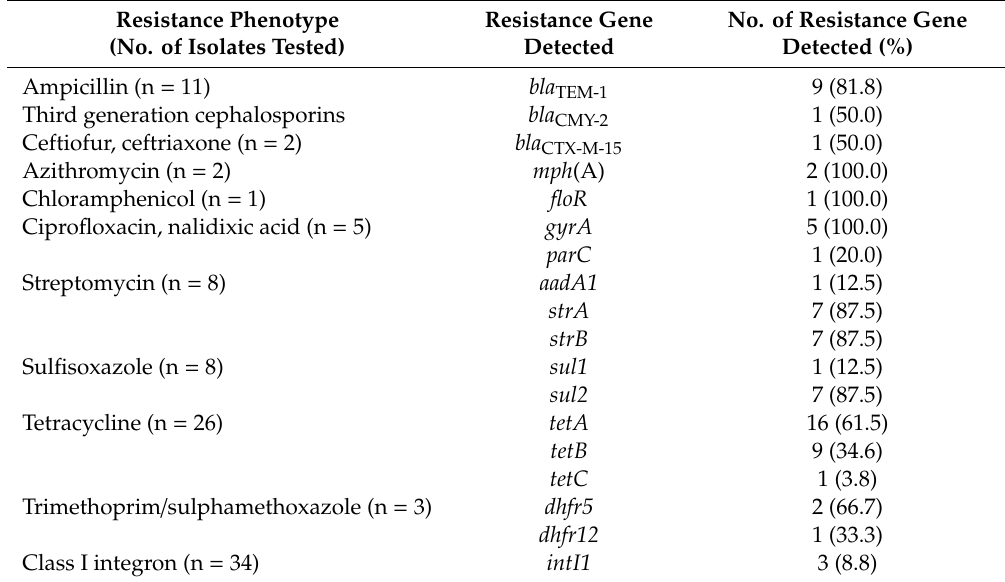
Table 2. Antimicrobial resistance genes detected in resistant E. coli isolates from surface